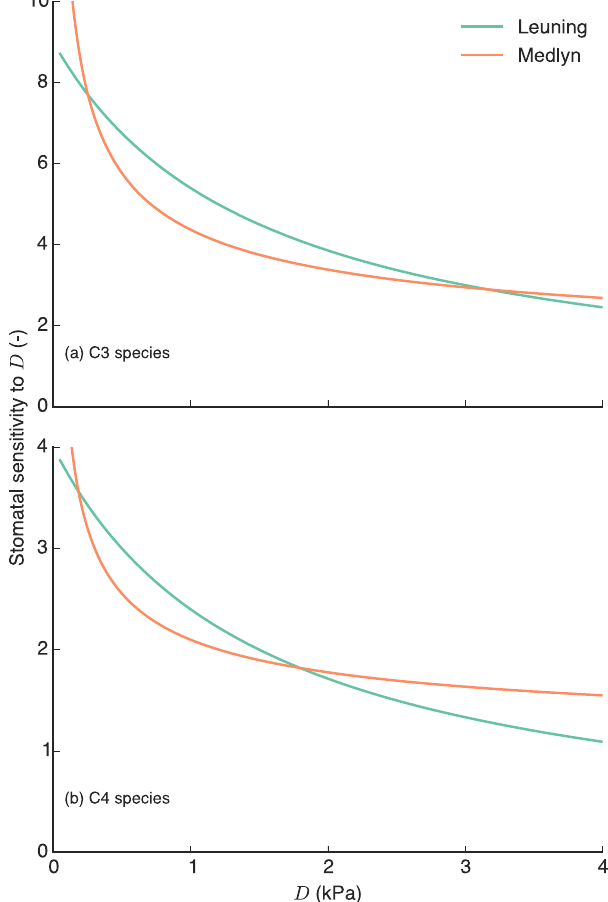
Figure 1. Stomatal sensitivity to increased vapour pressure deficit ( D) . The Leuning model has been parameterised in the same way as the CABLE model, for C3 species: a 1 = 9.0, D = 1.5kPa and for C4 plants: a 1 = 4.0, D 0 = 1.5kPa. The Medlyn model has been fit to output generated by the Leuning model using least squares for D ranging from 0.05 to 3kPa. The calibrated parameters for the Medlyn model were g 1 = 3.37 and g 1 = 1.09 for C3 and C4 species,